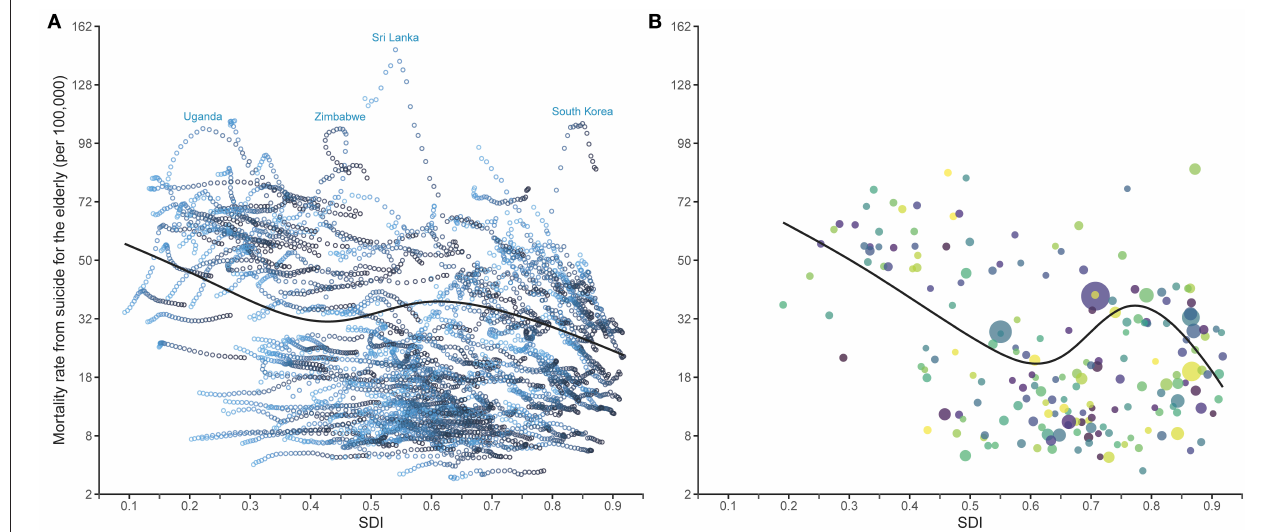
FIGURE 6 | Relationship between SDI and elderly suicide mortality rates from 1990 to 2017 (A) and in 2017 (B) for 195 countries and territories. SDI, Socio-demographic Index. Models are weighted by the elderly population. Y axes are shown after the square root transformation. The black curves represent the mortality rates expected on the basis of SDI alone, with linear model and restricted cubic spline smoother which includes 5 knots at the 5, 27.5, 50, 72.5, and 95th percentiles. In (A) , each hollow point corresponds to the mortality rate for a country or territory in a specific year. For a given location, the gradient colors from light to dark indicate the years from 1990 to 2017. Uganda, Zimbabwe, Sri Lanka, and South Korea were four countries with high suicide mortality rates whose temporal trends showed inverted U-shape curves. In (B) , each point of a specific color represents one country or territory, and the point size represents the elderly